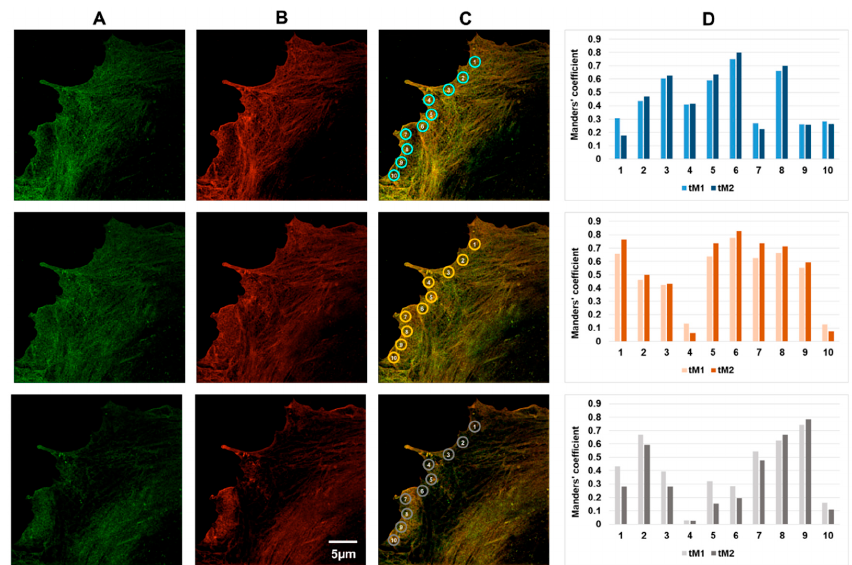
Figure 3. Colocalization of actin isoforms in the marginal regions of HPAEC. Vertical panel ( A ), immunofluorescent staining of β -actin; vertical panel ( B ), immunofluorescent staining of γ -actin; vertical panel ( C ), merged; vertical panel ( D ), three series of fluorescence intensity measurements in successive optical sections in the ROI defined by circles (marked in blue, orange and grey) at the cell edge. Measurements of the tM1 and tM2 threshold Manders’ coefficient in three adjacent optical sections are presented. Occasionally, in the adjacent sections for a given ROI, the Manders’ coefficients varied significantly. In general, lower coefficient values were observed at the stable cell edges.